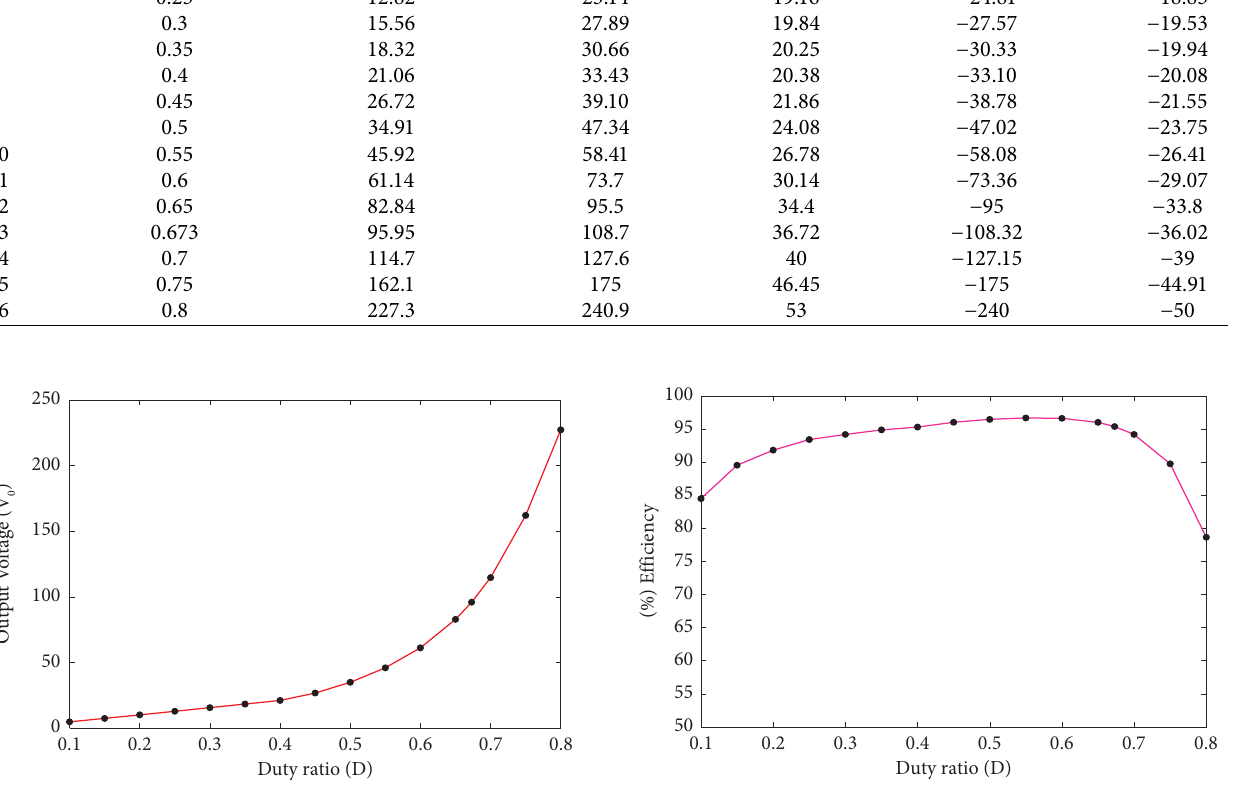
Figure 21: Performance curve of simulated output voltage ( V versus duty ratio ( D ).